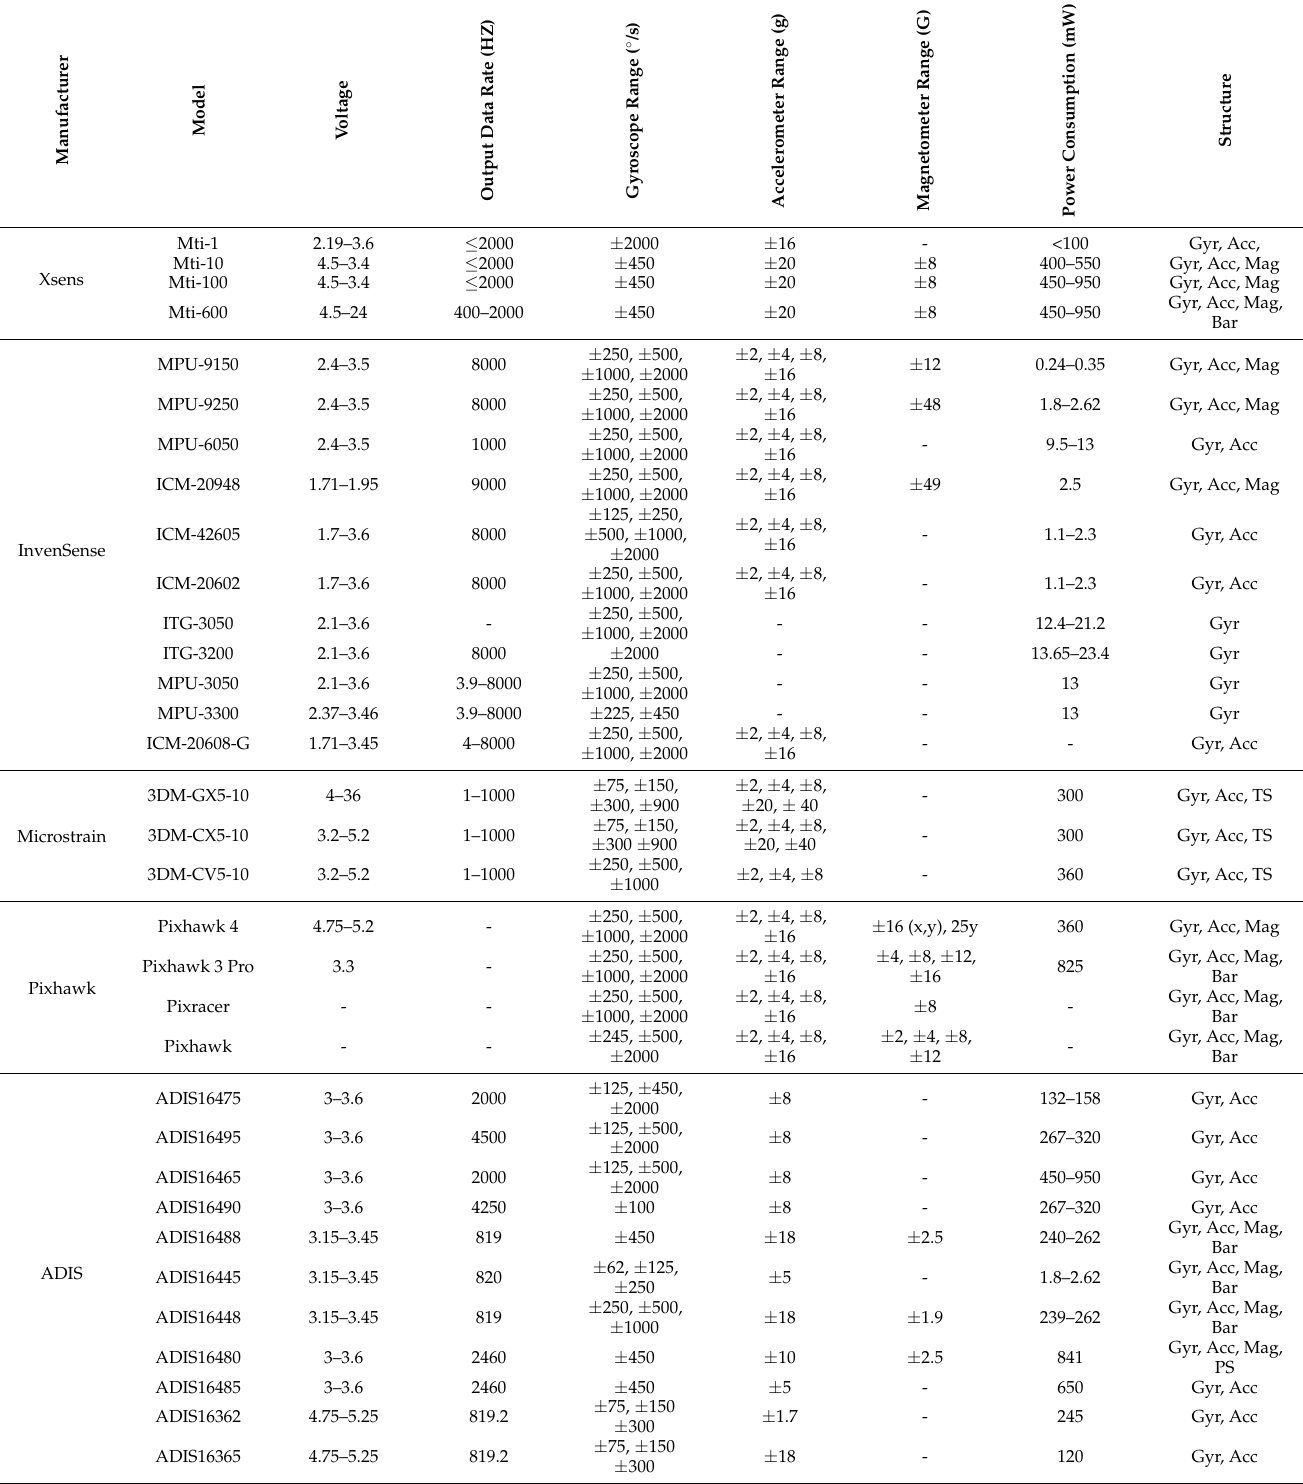
Table 1. Features of IMU’s models. (1/2) ([Gyr] = Gyroscope, [Acc] = Accelerometer, [Mag] =